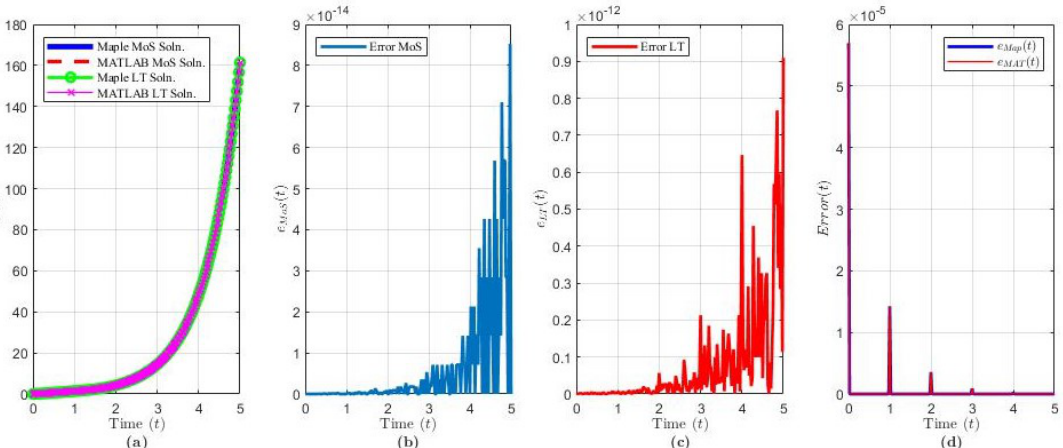
Figure 4. Solution results of Equation (21) over t ∈ [ 0,5 τ ] ( n = 2000 terms): plot of ( a ) the solution y ( t ) via each method and software, ( b ) e MoS ( t ) , ( c ) e LT ( t ) , ( d ) e Map ( t ) and e MAT ( t )